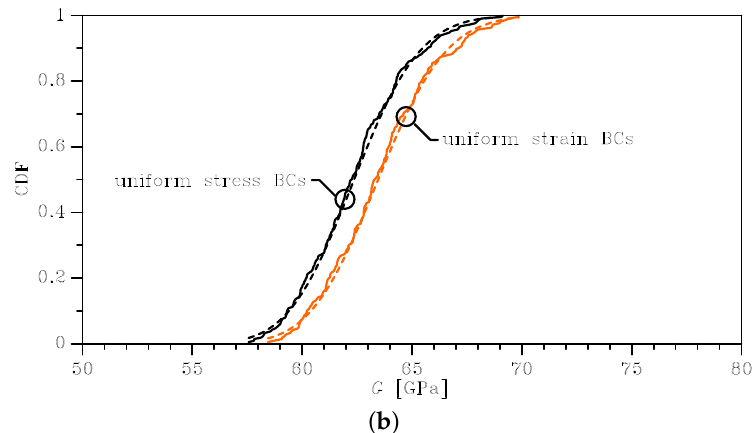
Figure 4. Effects of SVE size and BCs on the cumulative distribution function of the homogenized shear modulus G : ( a ) 2 × 2 µ m 2 SVE and ( b ) 3 × 3 µ m 2 SVE. Continuous lines represent the results of MC analyses, whereas dashed lines are the relevant lognormal interpolants.